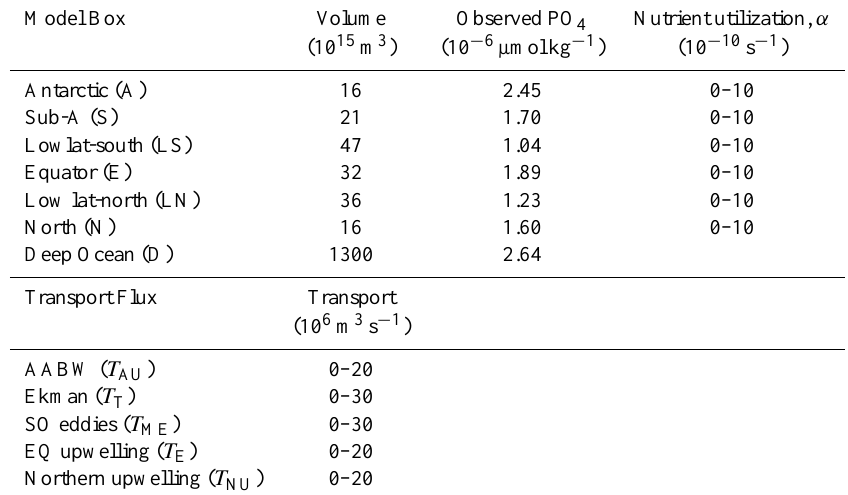
Table 1. Model parameters for the standard 7 box model. For each box the volume and the observed PO 4 concentrations for the real ocean between the same boundaries (derived from the World Ocean Atlas 2006) is given. The range of nutrient utilization rates for each box and transport fluxes between the boxes indicate the parameter space that is covered by the 10 7